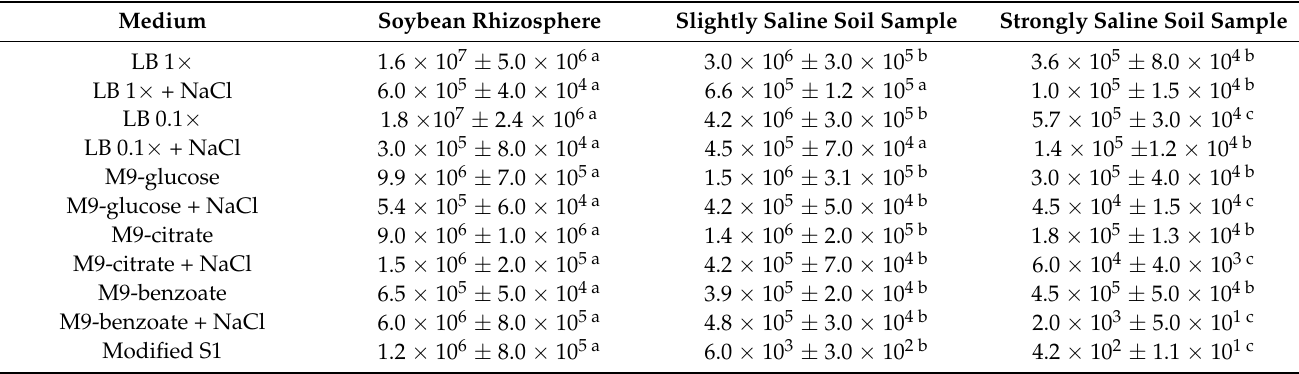
Table 2. Number of culturable cells in soil and rhizosphere